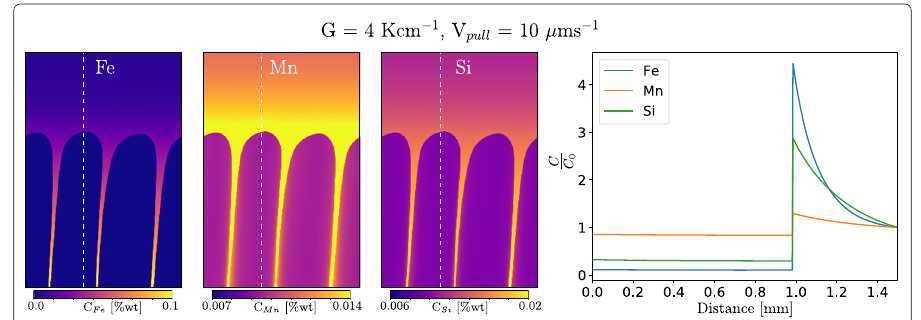
Fig. 9 (left) Concentration maps of Fe, Mn, Si at 400 s for the pulling velocity (V pull ) of 10 μ ms − 1 and temperature gradient (G) of 4 Kcm − 1 . (right) Concentration profiles for each element along the white dashed